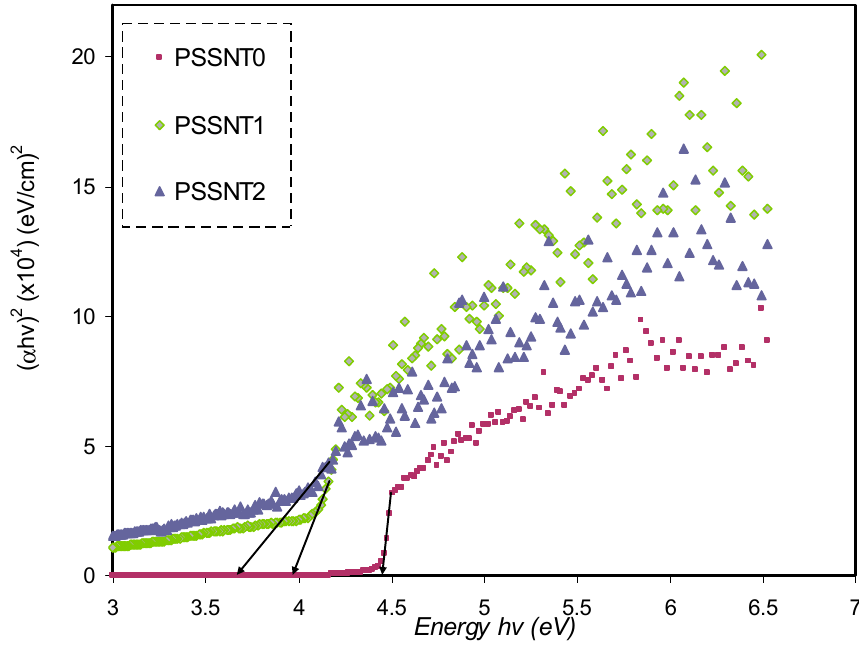
Figure 10. Plot of ( α h υ ) 2 versus photon energy for pure PS (PSSNT0), PSSNT1, and PSSNT2 NC films, where α represents the absorption coefficient.